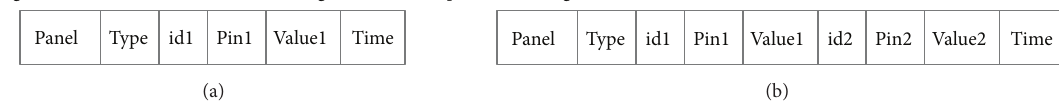
Figure 6: Message fields format for Smart Panel version 1P: (a) command for light devices; (b) command for other automated devices.